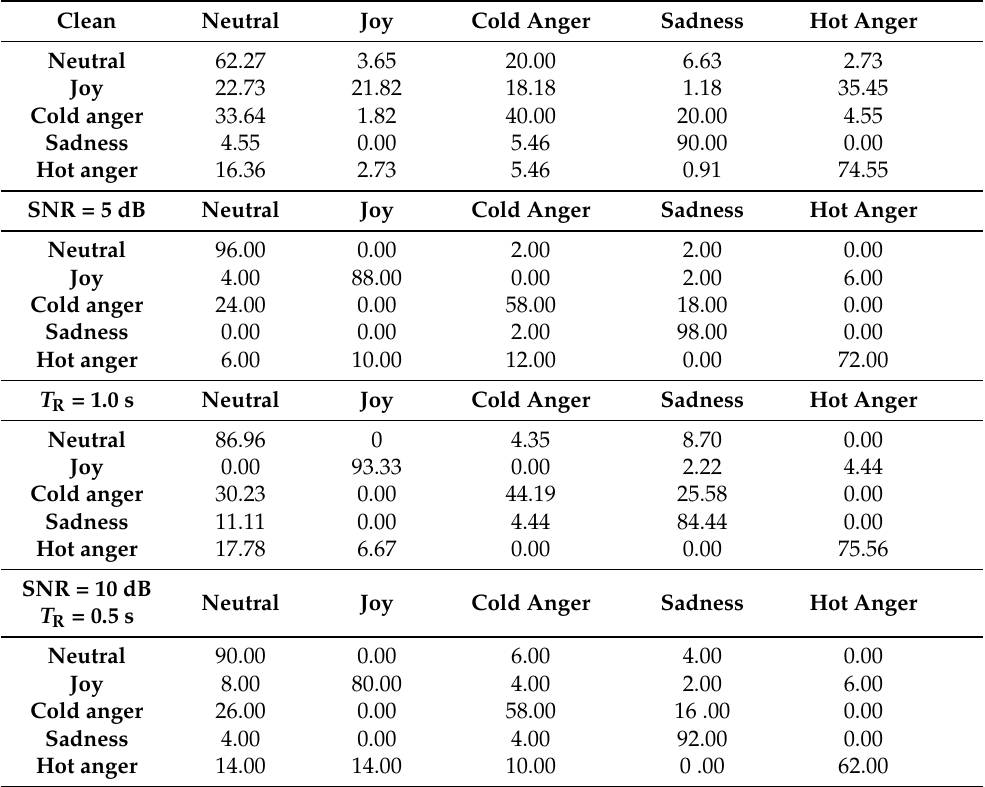
Table 1. Mean confusion matrix of vocal-emotion-recognition results (in percent). The confu- sion matrix is presented as a percentage with stimuli organized vertically and response categories organized horizontally.